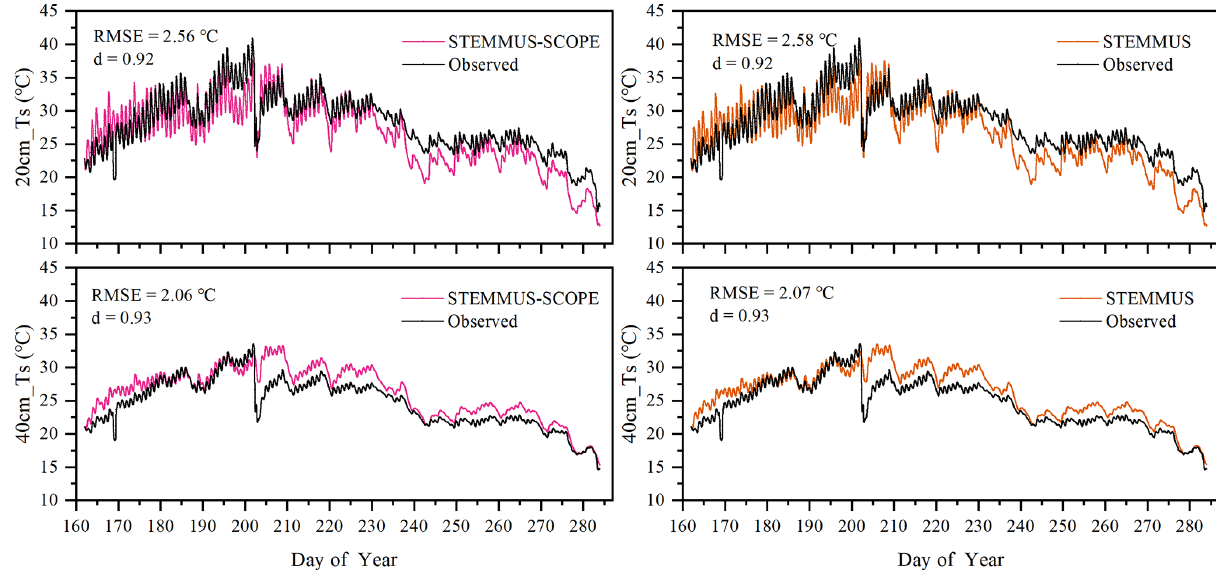
Figure 4. Comparison of observed and modeled soil temperature at 20 (20cm_Ts) and 40cm (40cm_Ts) depth for the maize cropland at Yangling